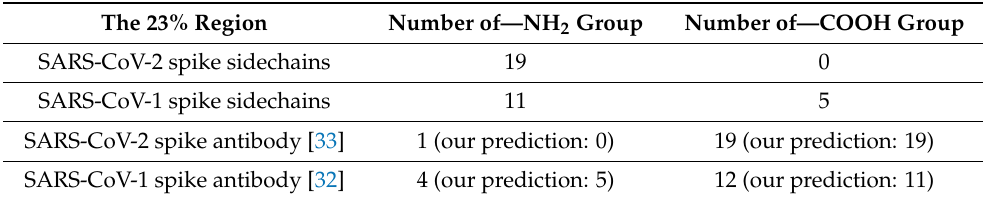
Table 1. The number of binding sites in SARS-CoV-2/SARS-CoV-1 spike proteins and their antibodies